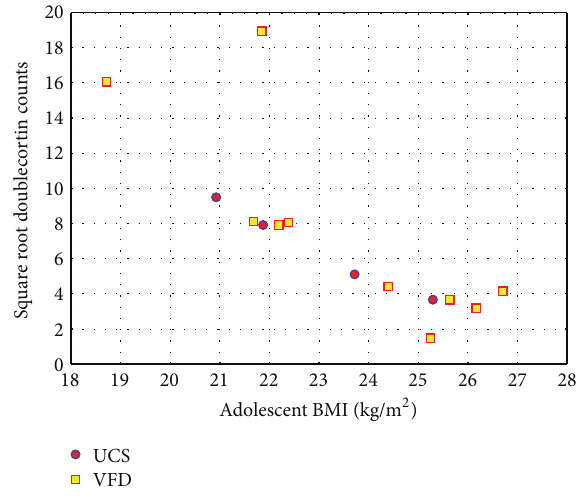
Figure2:Predictionofadultsquarerootdoublecortinbyadolescent body mass index. There was no rearing effect for SQRT doublecortin [ 𝐹 = 1.18 ; 𝑃 = 0.30 ] whereas adolescent body mass index predicted adult SQRT doublecortin [ 𝐹1, 11 = 22.48 ; 𝑃 = 0.0006 ]. Post hoc Spearman 𝑟 = −0.88 ; 𝑁 = 14 ; 𝑃 = 0.00002 . Partial 𝜂 2 = 0.67 (effect size ≥ 0.14 = large effect size). Red circles: USC (unstressed controls); blue circles: